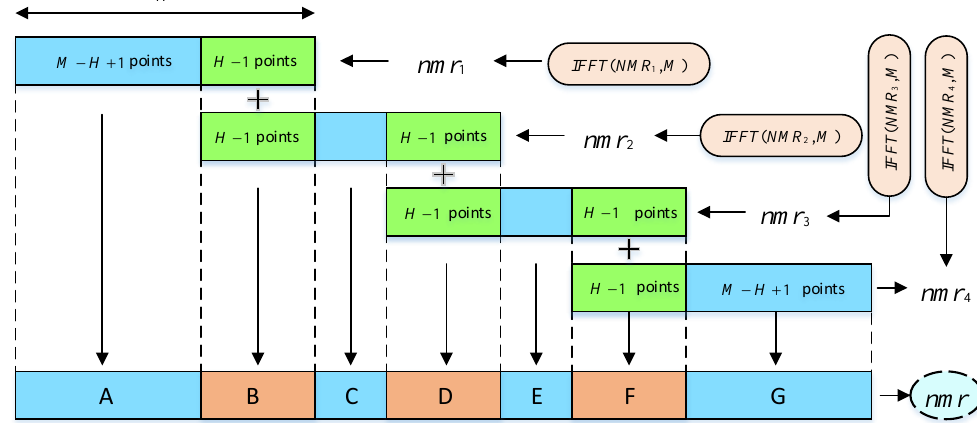
Figure 6. Estimated MRS signal construction via the overlap-add method after multi-frame spectral subtraction and fast Fourier inverse transform.